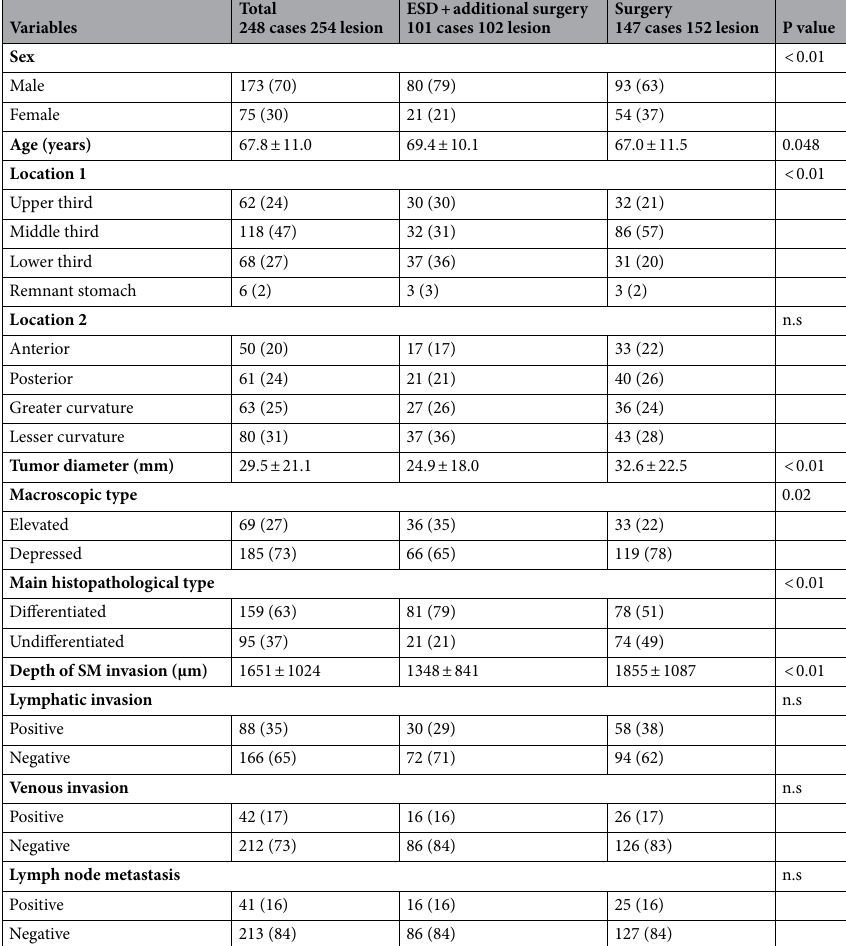
Table 1. Clinicopathological features of T1b2 gastric cancer.